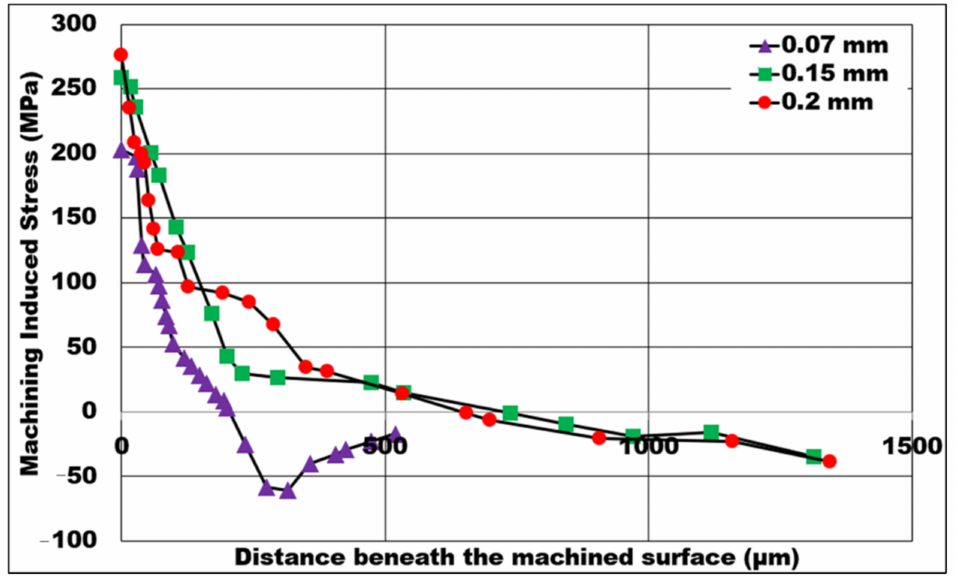
Figure 9. FE simulation of the effect of uncut chip thickness on machining-induced stress for 10% volume fraction syntactic foam (Vc = 50